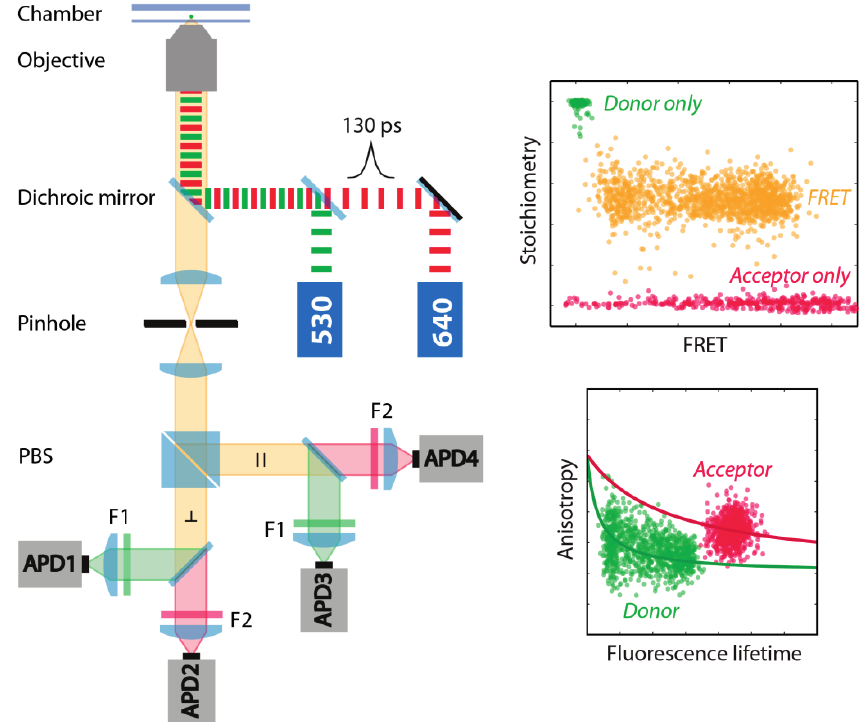
Figure 6. Schematic illustration of the home-built confocal TCSPC microscope. Donor and acceptor fluorophores were excited at 530 nm and 640 nm with pulsed-interleaved excitation (PIE) with a total repetition rate of 50 MHz to remove donor only and acceptor only molecules from the analysis. Donor and acceptor anisotropy and fluorescence lifetime are measured simultaneously to obtain information about the microenvironment and rotational freedom of the fluorophores. A stoichiometry vs. FRET plot ( S - E -plot) allows the identification of FRET molecules (orange), donor-only molecules (green) and acceptor-only molecules (red). PBS: polarizing beam splitter; APD: avalanche photo diode; F1/F2: bandpass